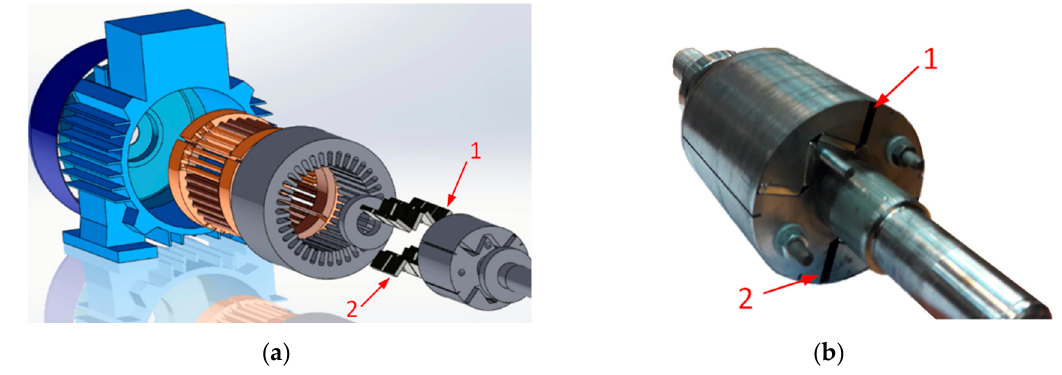
Figure 20. Back EMF measurements with: ( a ) healthy magnets and ( b ) partially demagnetized magnets.